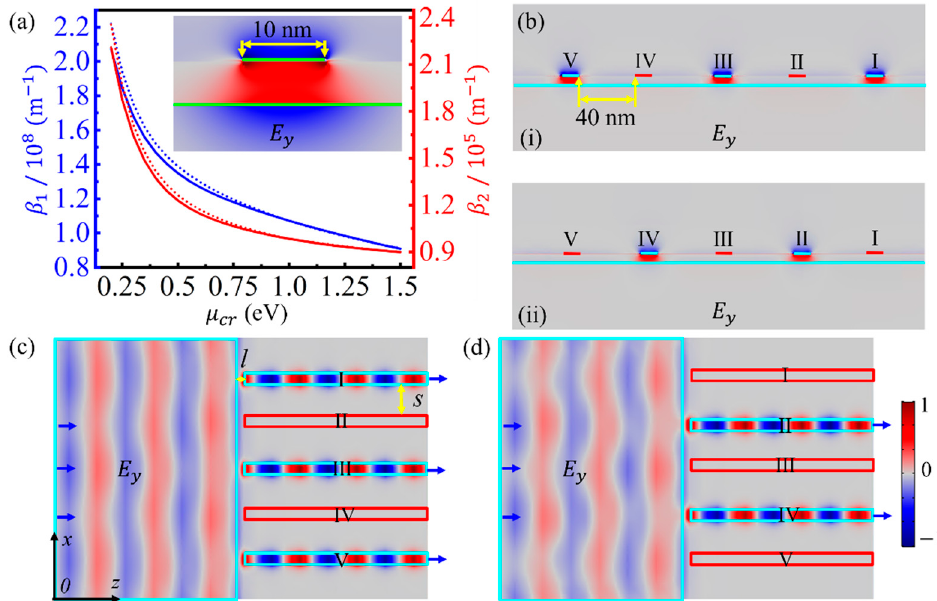
Figure 4. ( a ) Dependences of the real and imaginary parts of β on the chemical potential of the GNR. The inset in ( a ) shows the distribution of E y . ( b ) Distributions of E y on the output plane of a multichannel optical switch, parts ( i ) and ( ii ) corresponding to ( c ) and ( d ), respectively. ( c , d ) Distributions of E y on the center plane of the dielectric spacer for GNRs with different chemical potentials. The interior areas of the cyan and red boxes (or lines) represent graphene with chemical potentials of 1.0 and 0.3 eV, respectively. All electric field distributions share the same color legend. The propagation of GSPPs in a GNRGW array with five GNRs is further simulated.